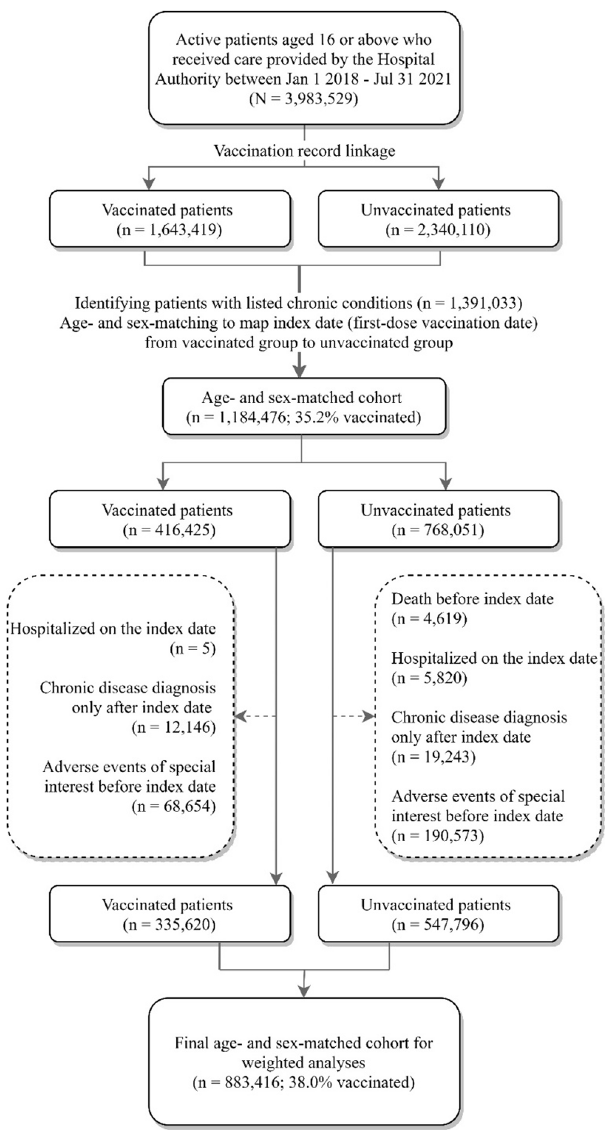
Fig. 1 Flow chart of cohort selection. A total of 883,416 patients were included in the fi nal cohort with 38.0% of the patients